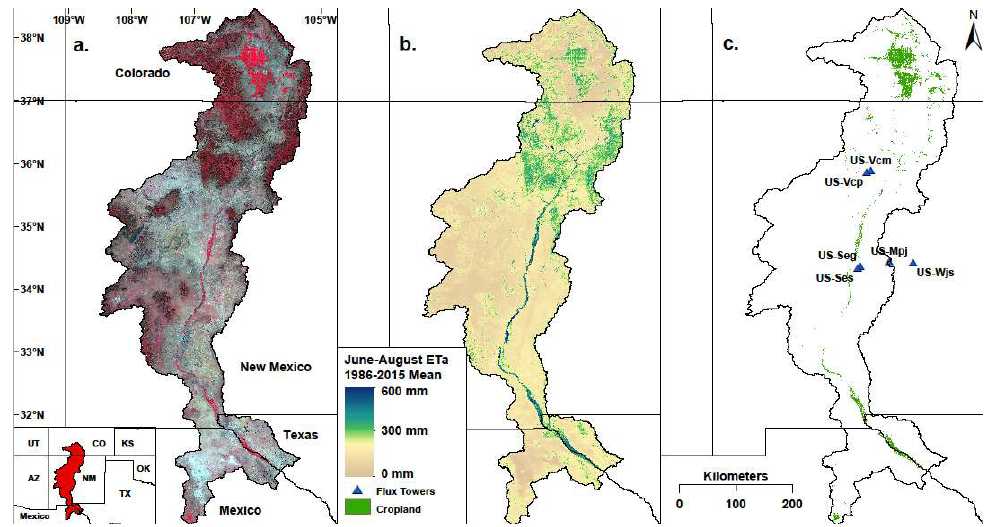
Figure 1. The Upper Rio Grande Basin including ( a ) false color composite (near infra-red, red, and green) of Landsat based on greenest-pixel (NDVI) from 2010–2015 with dense vegetation shown in red; ( b ) 1986–2015 mean Operational Simplified Surface Energy Balance (SSEBop) actual evapotranspiration ( ETa ) from June–August (summer), and ( c ) maximum cropland extent for the basin with locations of the six eddy-covariance flux towers.